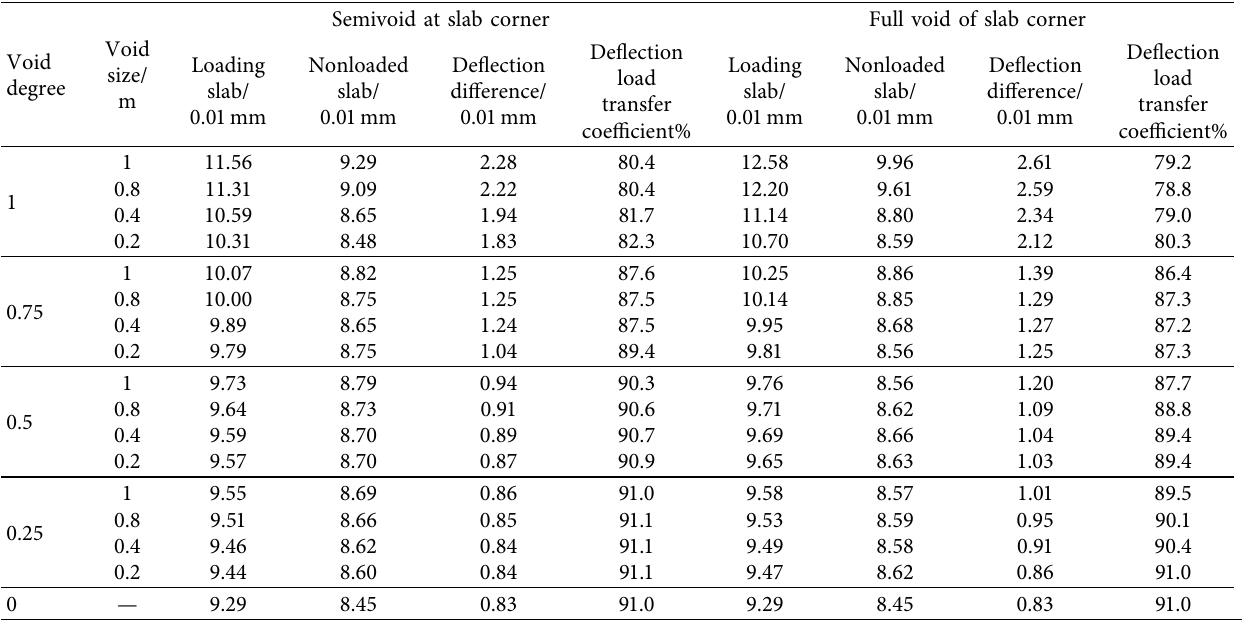
Table 6: Deflection values of loaded and nonloaded cement concrete slabs under different void